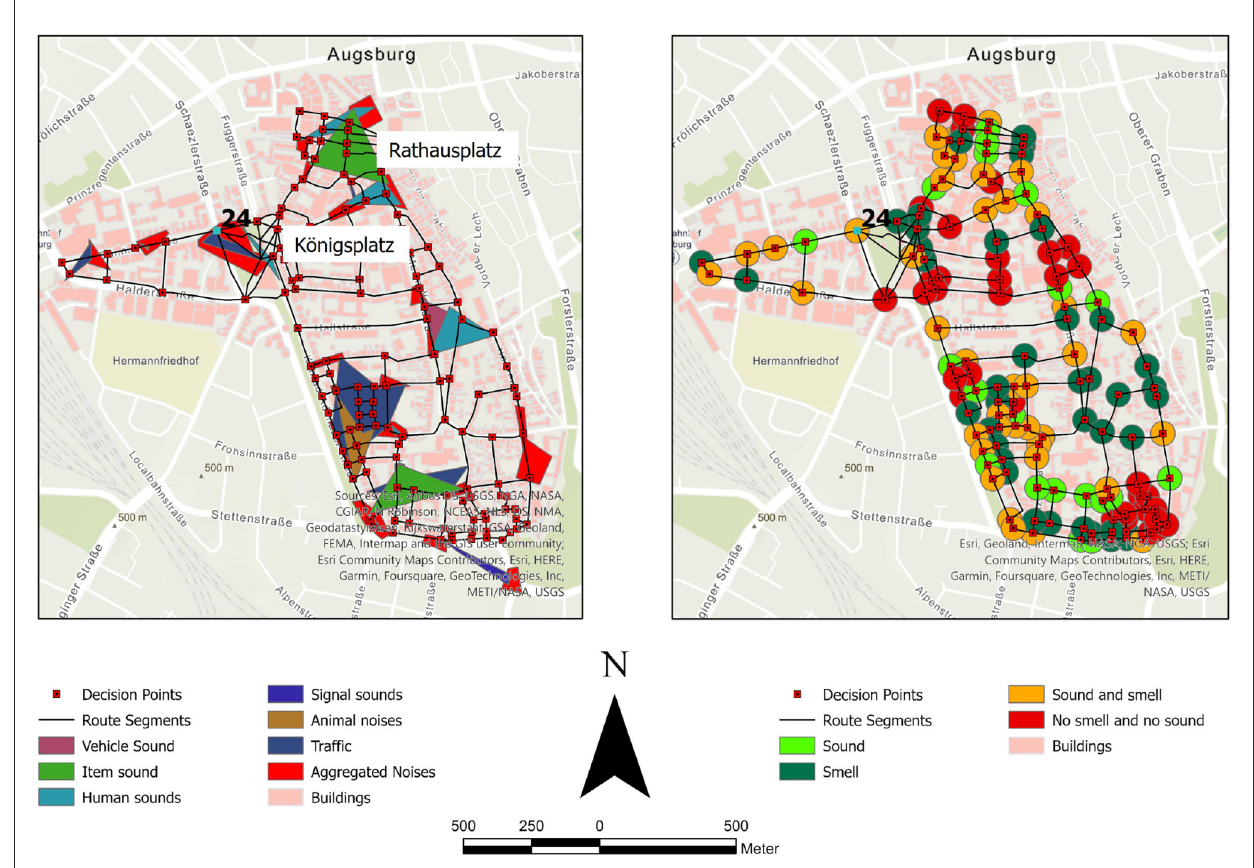
FIGURE1 Sound regions (Left) and availability of sound and smells at street intersections (Right)